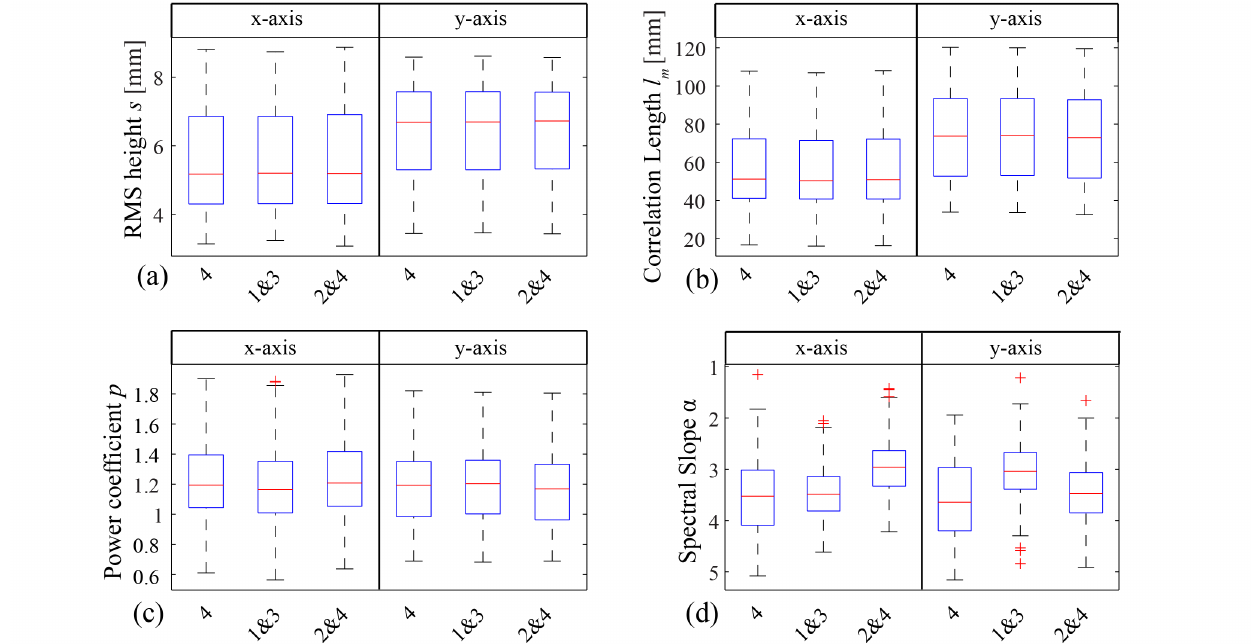
Figure 12. The values of ( a ) RMS height, ( b ) model correlation length, ( c ) power coefficient and ( d ) spectral slope, estimated independently, once from the rows (x-axis section) and another time from the columns (y-axis section), over Subarea 3. The names of each box-plot show the scans used to generate the DEMs: all four scans (4), the merged Scan 1 and Scan 3 (1&3) and the merged Scan 2 and Scan 4